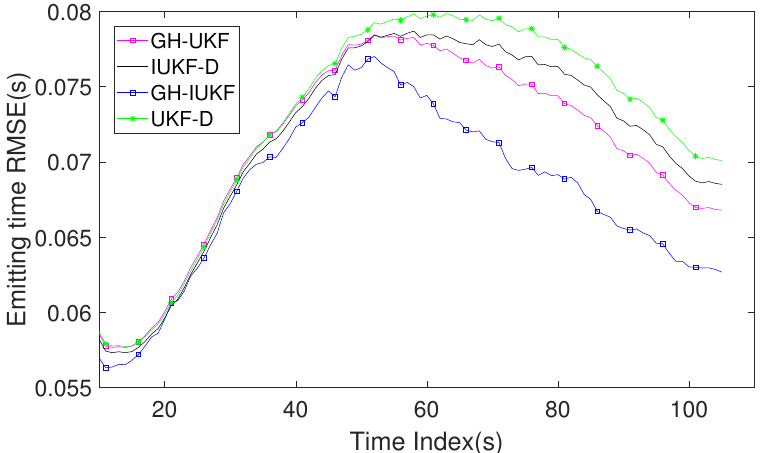
Figure 8. RMSE of the estimated signal emission time versus time index